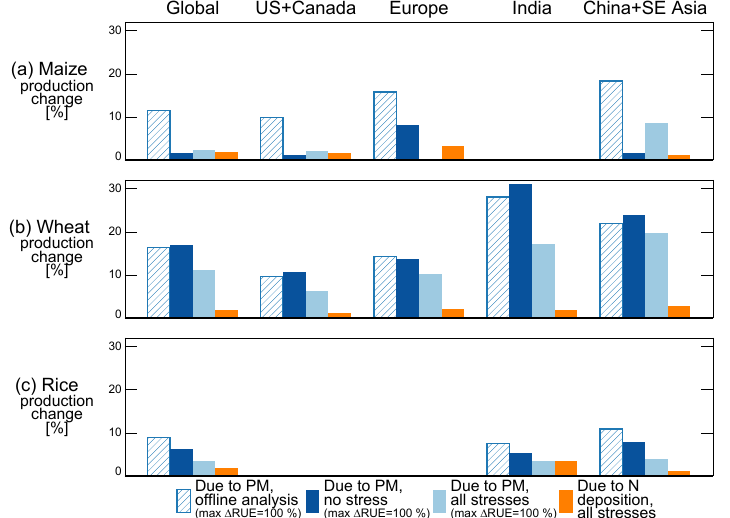
Figure 4. Regional relative change in crop production due to PM with max (cid:49) RUE = 100%: offline analysis from Schiferl and Heald (2018) (blue bars with hatching), pDSSAT simulation with no stress (dark blue bars), and pDSSAT simulation with water and nitrogen stresses (light blue bars). Change due to nitrogen (N) deposition in orange. For growing season ending in 2010 for (a) maize, (b) wheat, and (c) rice. Regions with a base production lower than 5% of the global total are not